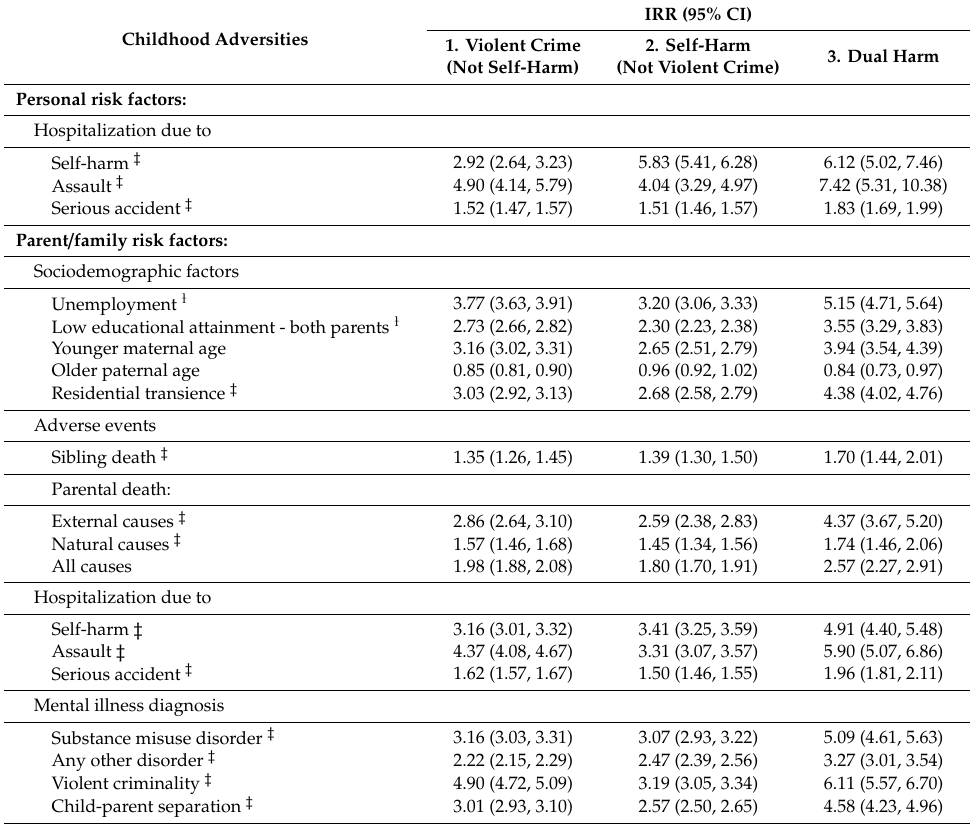
Table 3. Incidence rate ratios for adverse childhood experiences (reported in Table 1) across the 3 behavioral outcome